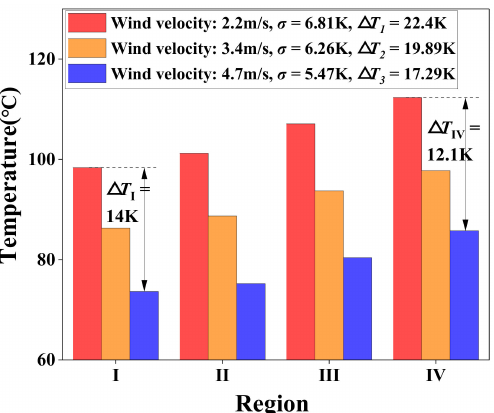
Figure 11. Winding temperature distribution under a current density of 20.6 A/mm 2 and different wind velocities (2.2 m/s, 3.4 m/s and 4.7 m/s).